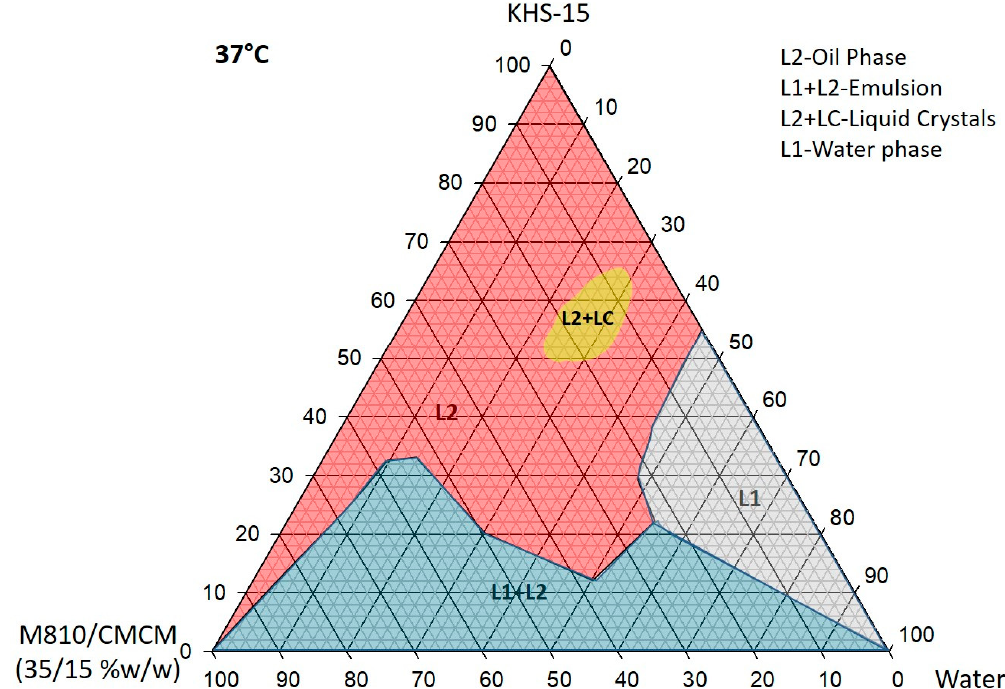
Figure 2. Ternary phase diagram of M810:CMCM (7:3)/HCO-30/water systems at 37 °C, in which L1 denotes a clear aqueous phase, L2 a transparent oily phase, L1 + L2 a milky emulsion, and L2 + LC an oily phase with liquid crystals.